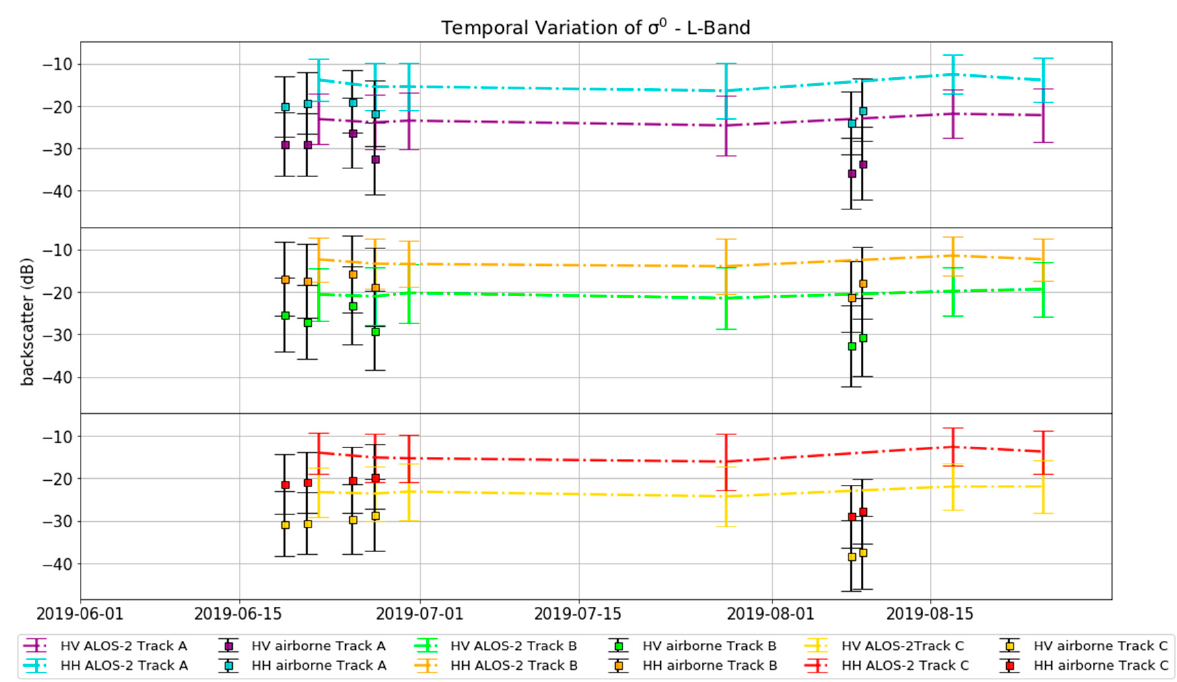
Figure 9. Temporal behavior of backscattering signals of L-band air- and space-borne data for the flight tracks A, B and